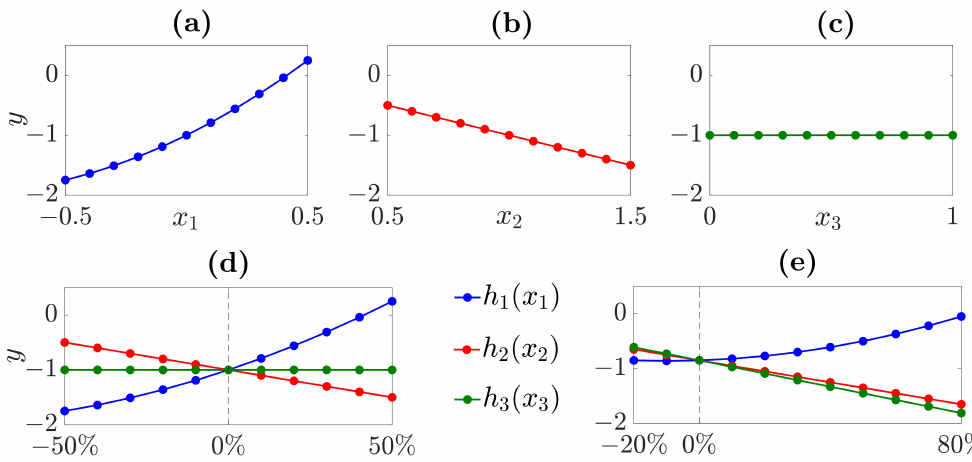
Figure 3. ( a – c ) One-way sensitivity functions for x 1 , x 2 , and x 3 , respectively, when the model inputs are moved individually across their variation range, while holding the other inputs at their base case values. ( d , e ) Spider plots of the one-way sensitivity functions when the base case is [ 0,1,0.5 ] and [ − 0.3,0.7,0.2 ] ,